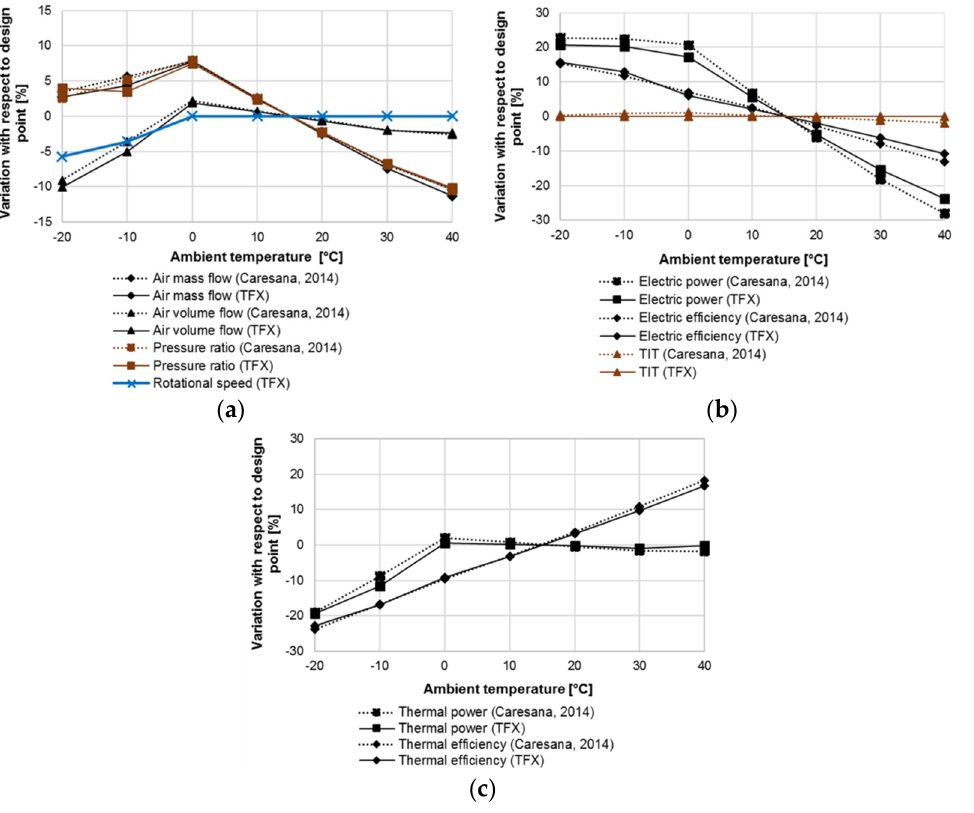
Figure 2. Model validation: effects of ambient temperature on ( a ) compressor characteristics; ( b ) electric power and efficiency; ( c ) thermal power and efficiency [33].